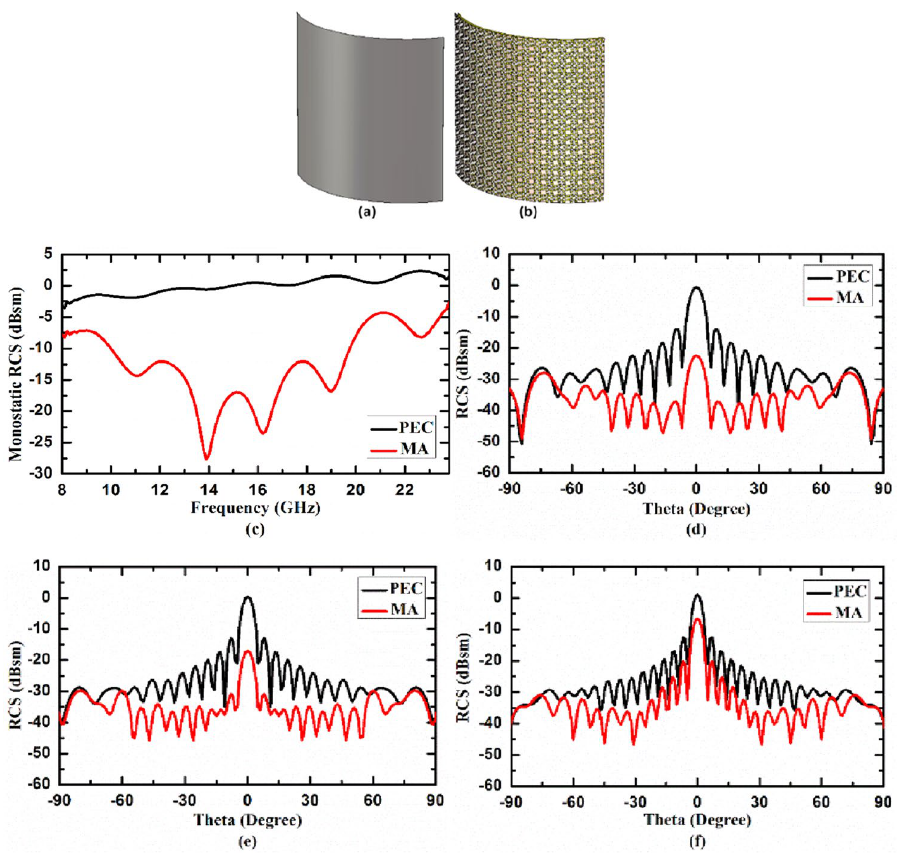
Figure 8. 3D view of cylindrically bent ( a ) PEC and ( b ) MA with radius of curvature 100 mm, ( c ) monostatic RCS, and bistatic RCS at ( d ) 14.84 GHz, ( e ) 17.99 GHz, ( f ) 21.14 GHz under normal